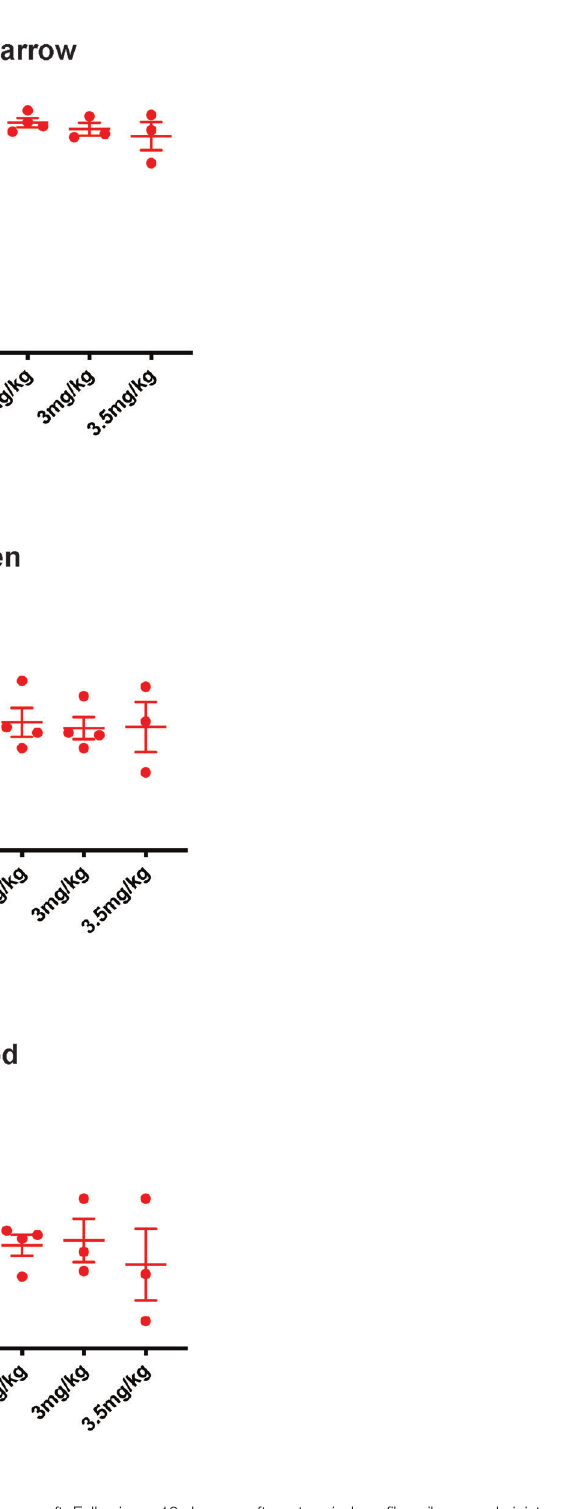
FIGURE 3 | Car fi lzomib monotherapy does not reduce leukemic burden in the PER-785 xenograft. Following a 12-day engraftment period, car fi lzomib was administered intravenously on days 1, 2, 8, 9, 15, and 16 with treatment groups comprising of vehicle control, 1.5, 2.0, 2.5, 3.0, 3.5, or 4.0 mg/kg dosing of car fi lzomib (n = 5 mice per group). Mice were sacri fi ced 3 weeks from the start of therapy and leukemia burden was determined by measuring the percentage of human CD19 + CD45 + cells in the bone marrow, spleen, and peripheral blood. Error bars represent mean ± standard error of